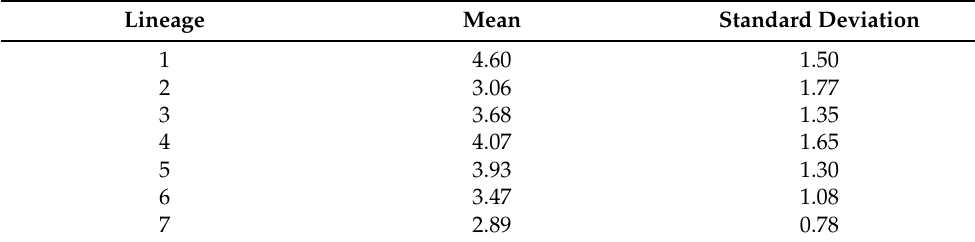
Table 2. Mean and standard deviation of holes in spoligotypes per lineage Lineage Mean Standard